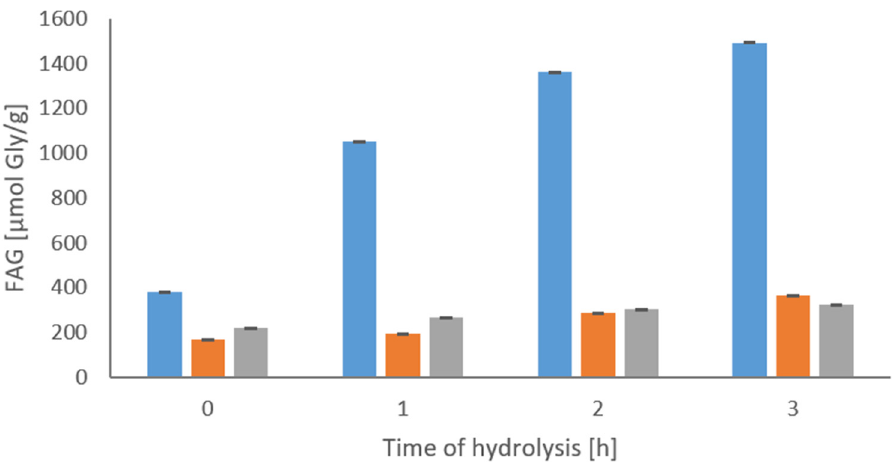
Figure 2. Free amino group’s content (FAG) in casein hydrolysates obtained with the extracellular serine protease preparation from Yarrowia lipolytica yeast, at the dose of 500 U/g soluble in water [blue] and in PTA [orange], and in the control sample—non-hydrolyzed isoelectric casein